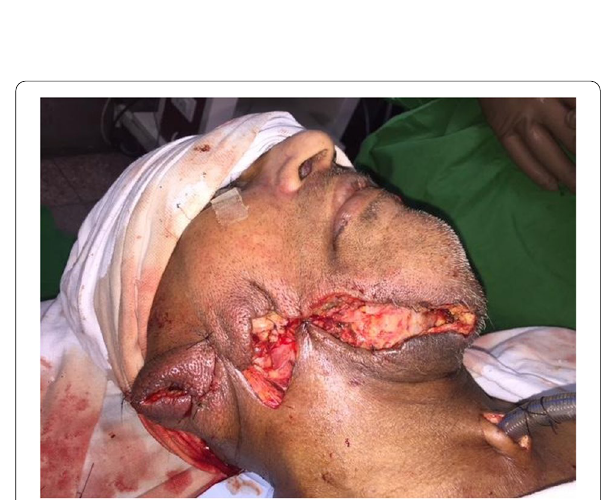
Fig. 2 Surgically excised tumor revealing a dimension of 30 cm 20 cm with a weight of 3.5 kg ×